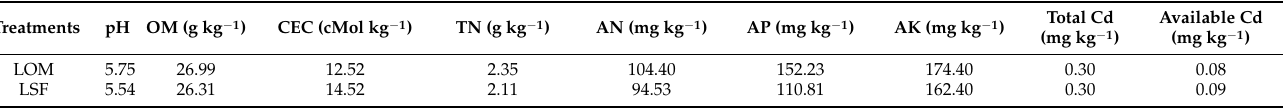
Table 1. Characteristics in soil of LOM and LSF experiment areas.